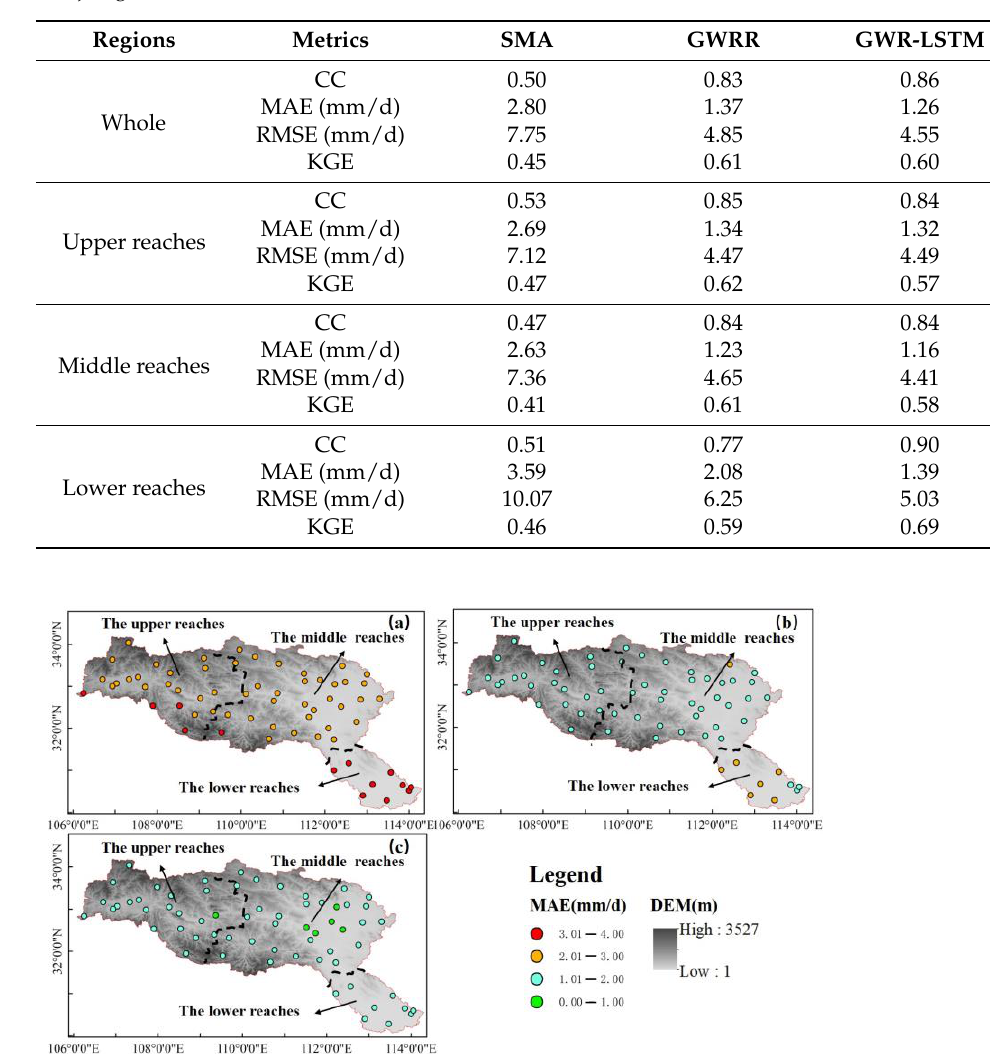
Figure 11. Spatial distribution of MAE with reference to gauge observations for ( a ) SMA, ( b ) BMA, and ( c ) GWR-LSTM.